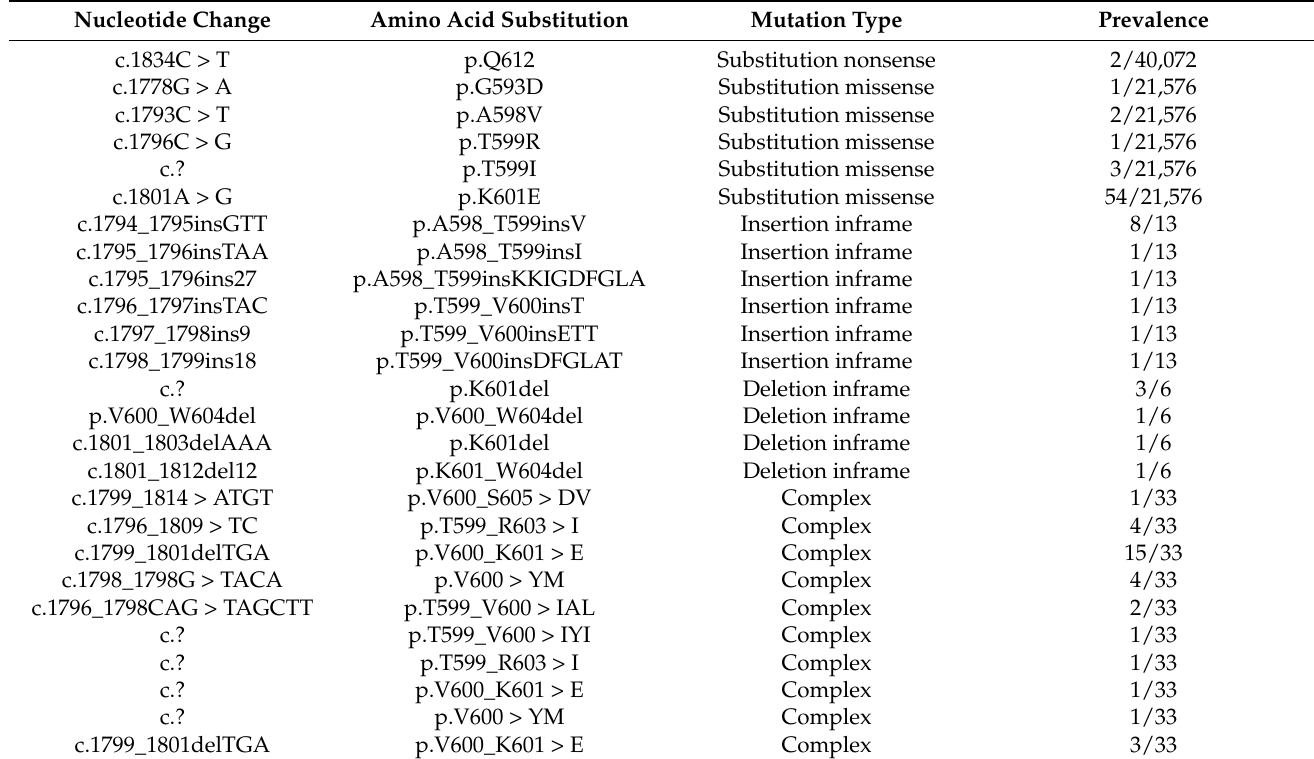
Table 2. Rare BRAF mutation in thyroid cancers according to the COSMIC